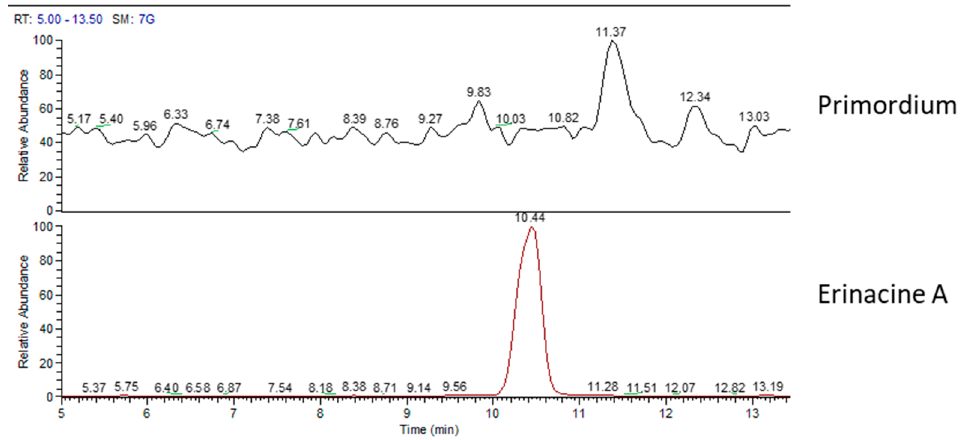
Figure 7. MS (mass spectrum) traces of primordium (top) and erinacine A molecule standard (bottom).